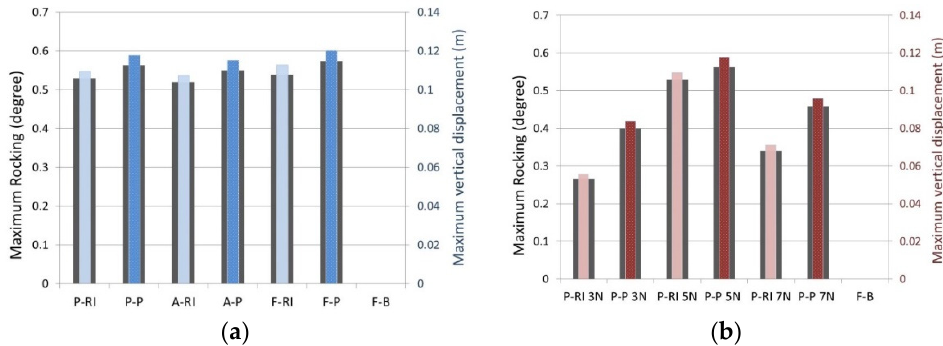
Figure 11. Maximum rocking and vertical displacement in the analyzed systems with different conditions. ( a ) 5-storey Building; ( b ) 3-, 5- and 7-storey Buildings.